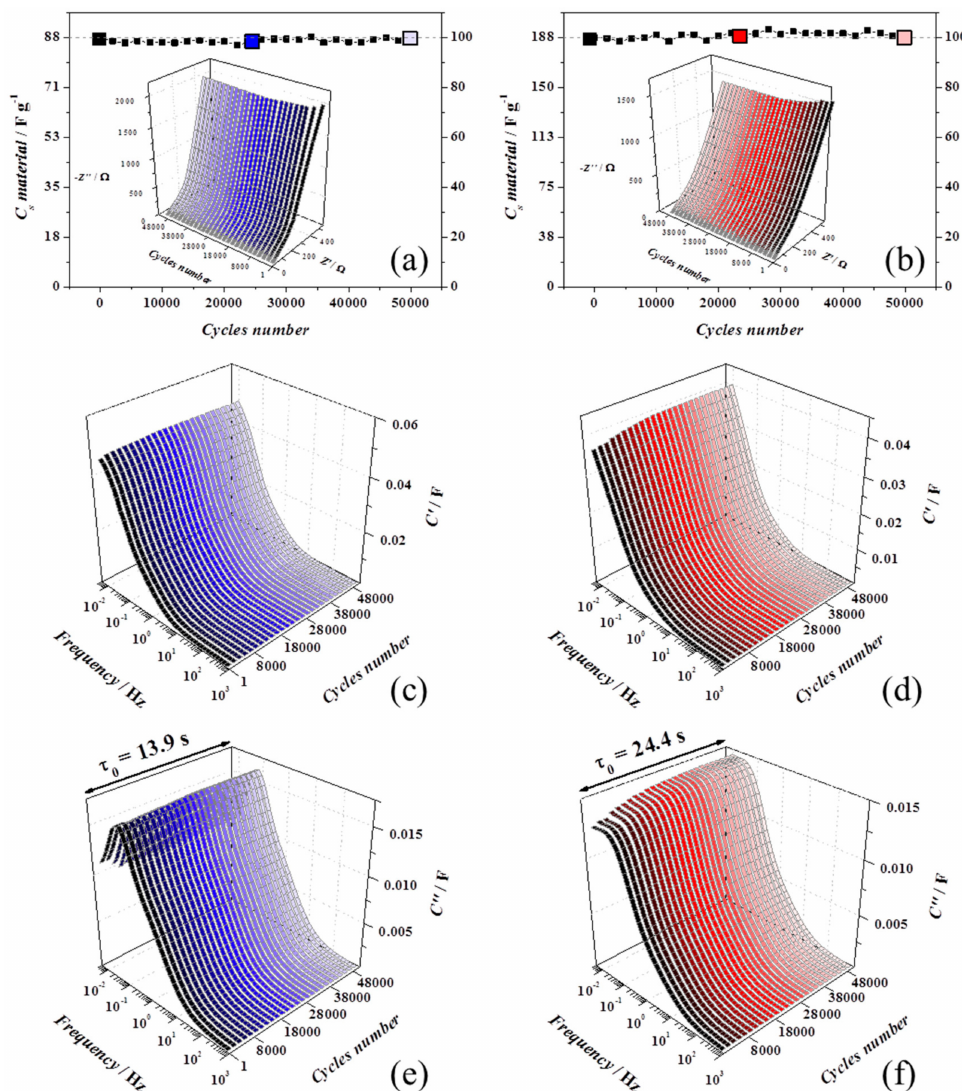
Figure 5. All the ageing experiments were carried out in device with 1 M Na 2 SO 4 . rGO- vit C experiments are reported on the left-hand side (blue shadows) and rGO-MoO 2 -vitC experiments are presented on the right-hand side (red shadows). AC impedance spectra were carried out at 0 V every 1000 cycles. ( a , b ) Capacitance retention and Nyquist plots in the inset, ( c , d ) real part of the complex capacitance spectra (C’), and ( e , f ) imaginary part of the complex capacitance spectra (C”) with the relaxation time constant of the device.